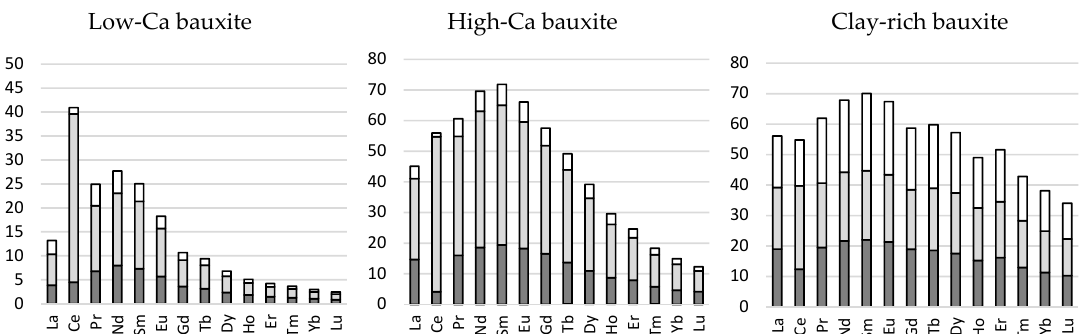
Figure 4. Recovery (%) of individual REE using sequential extraction. Leaching from step 1 exchangeable (magnesium chloride) is not visible; step 2, dark grey—acid soluble (acetic acid); step 3, pale grey—reducible (hydroxylamine hydrochloride); step 4, white—oxidisable (hydrogen peroxide).